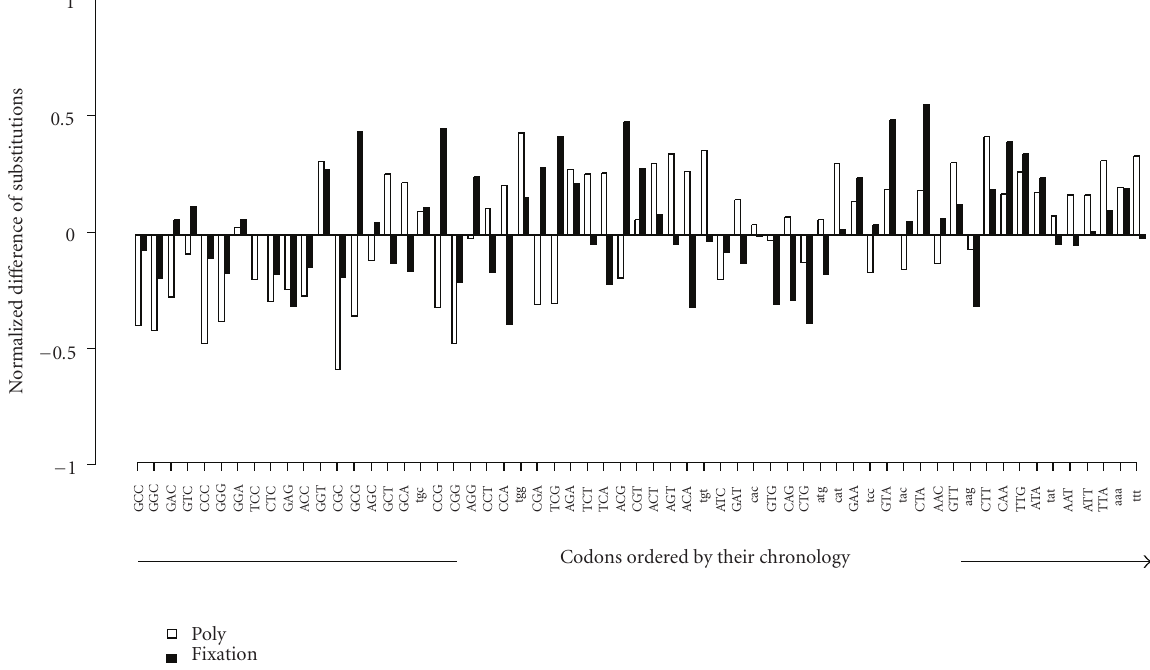
Figure 2: Normalized di ff erence of codon changes (gain and loss) at the polymorphic and fixed sites in amino-acid coding regions. The normalized di ff erence of a codon was defined as the di ff erence of the number of mutations removing the codon from that creating the codon and divided by the total number of mutations in the codon. Codons are ordered (left: ancient; right: recent) in their temporal order in the genetic code according to Trifonov [2]. The codons associated with codon capture are in lower case.